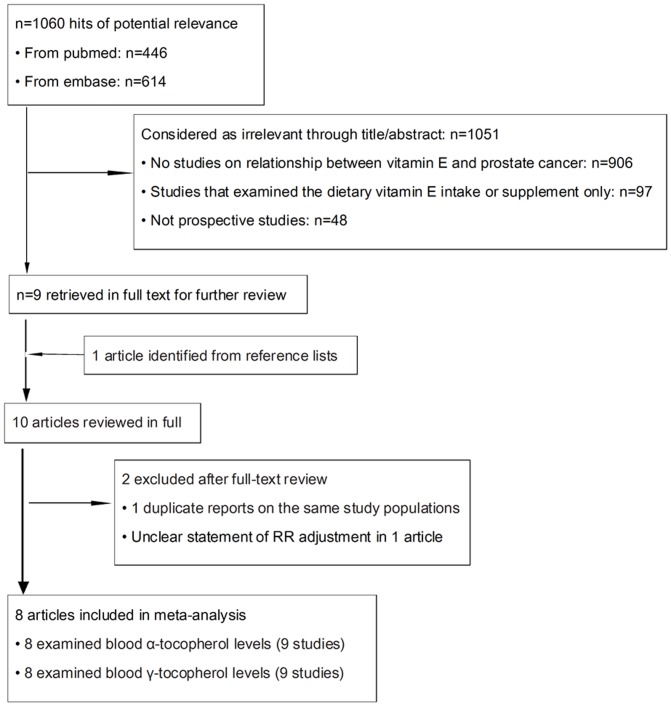
Literature search and study selection.